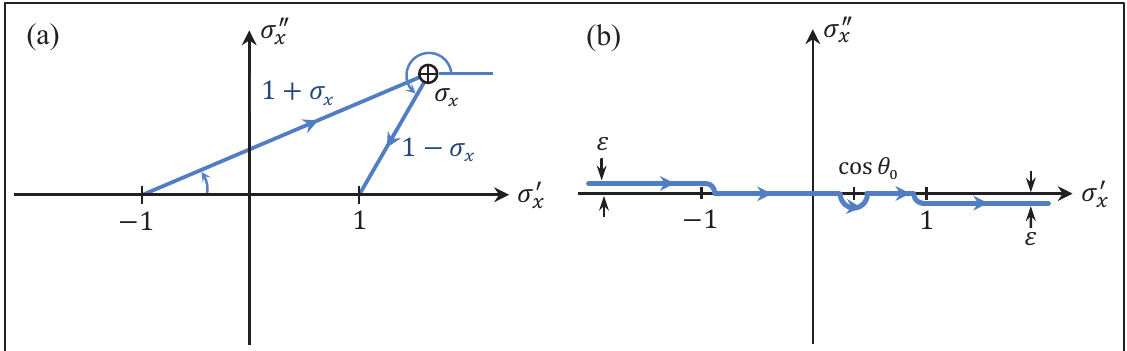
Fig.6 . (a) In the complex (cid:2026) -plane, where the phase of the complex numbers 1 ± (cid:2026) (cid:3051) (cid:4593) axis, the range of both angles is confined to the ( (cid:3398)(cid:2024) , (cid:2024) ] interval. (b) The wise from the positive (cid:2026) (cid:3051)